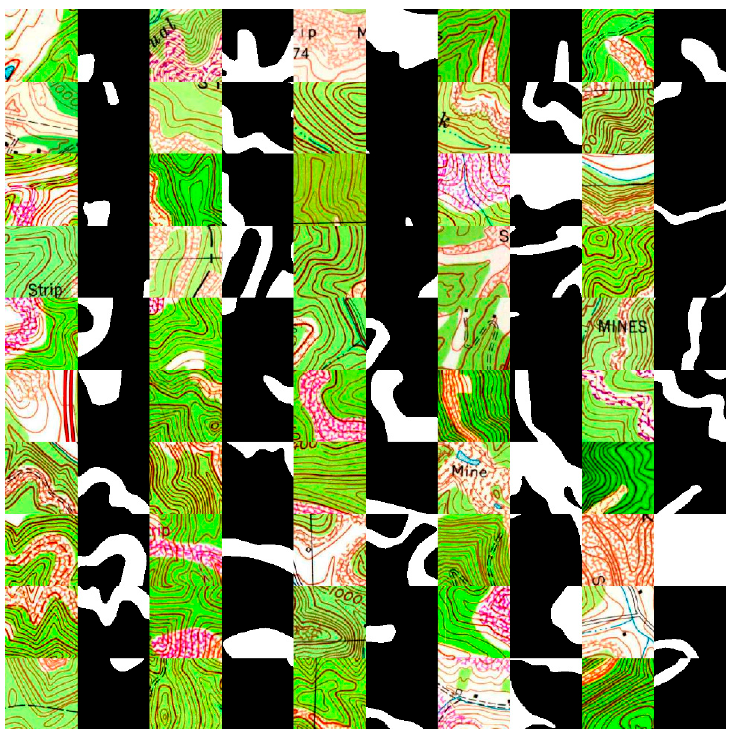
Figure 5. Example 128-by-128 pixel image chips and, in each adjacent column, associated masks used to train, test, and validate the semantic segmentation model. White areas in the mask indicate pixels mapped to the mine feature class while black indicates background. Topographic maps obtained from the USGS and the National Map’s Historical Topographic Map Collection.